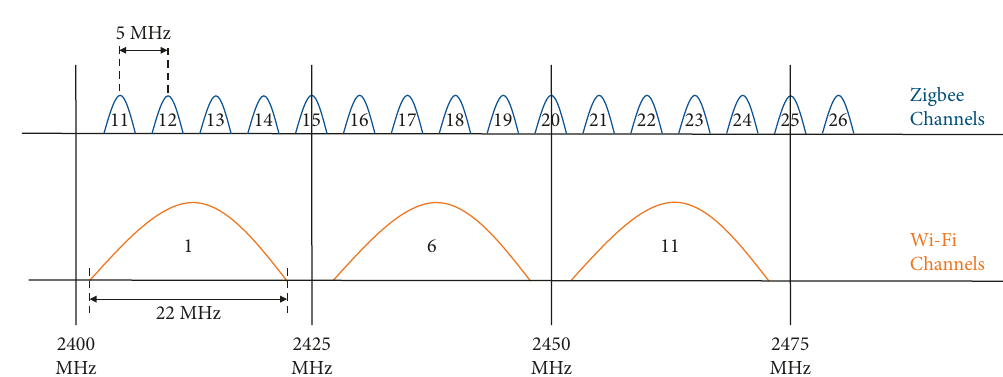
Figure 1: Zigbee and Wi-Fi channel distribution.